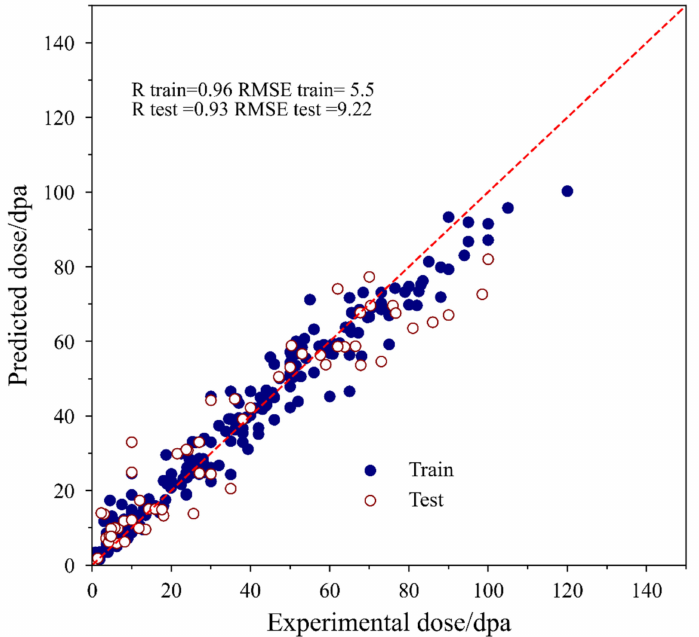
Figure 3. Comparison of the predicted and experimental results for the onset dose of swelling using the RFR